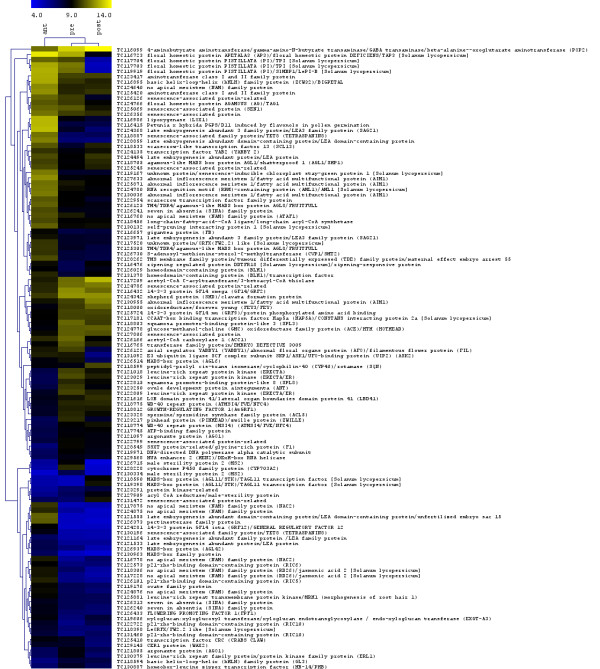
Hierarchical clustering of expression for the differentially expressed genes involved in developmental processes. Differentially expressed genes putatively involved in developmental process were selected by multtest package in R. Shown is the heat map representation for averaged expression intensities. All data are presented as log2 (RMA expression value).